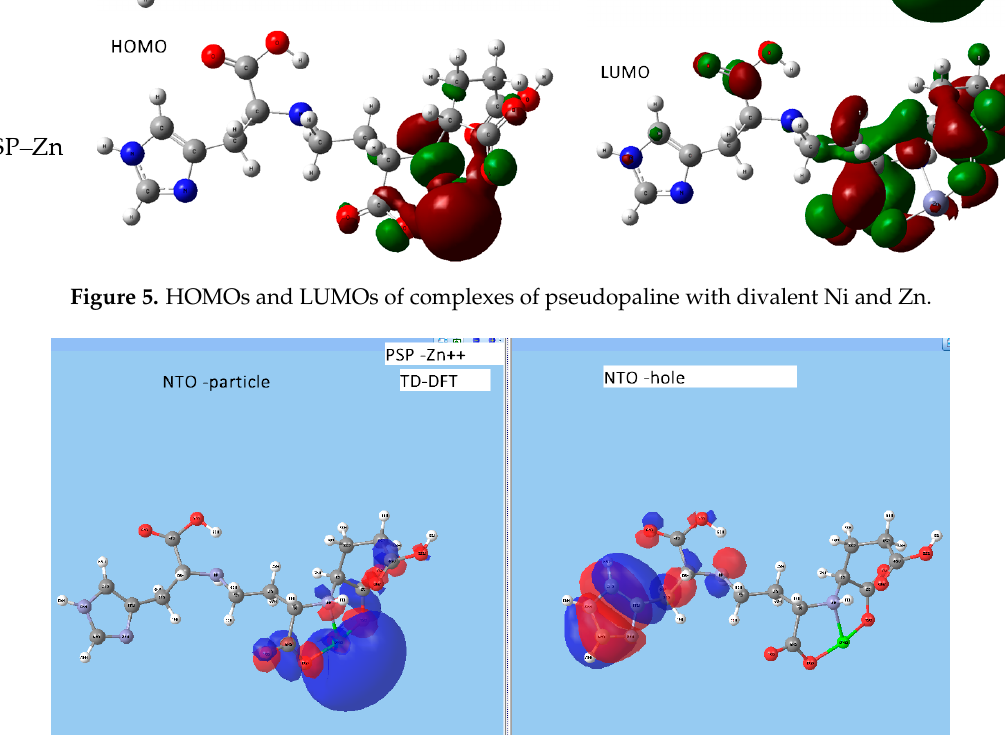
Figure 6. Natural transition (molecular) orbitals (NTOs) corresponding to FMOs of PSP–Zn. Staphylopine with Divalent Ni, Cu, and Zn